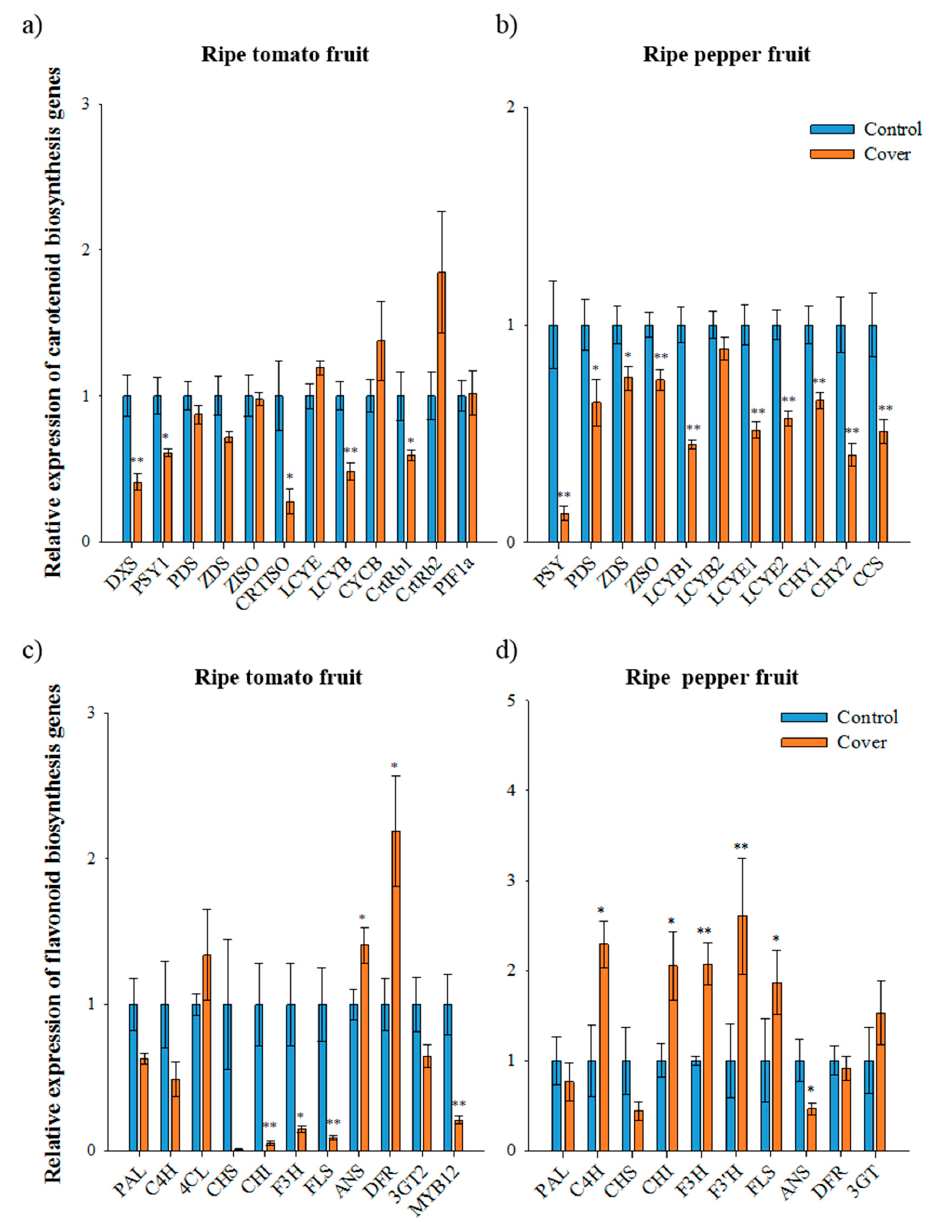
Figure 3. Relative expression of carotenoid and flavonoid biosynthetic genes in ripe fruits under normal and cover conditions analyzed using qRT-PCR. The expression of carotenoid biosynthetic genes in ripe tomato fruit (second trial) ( a ) and ripe pepper fruit (first trial) ( b ). The expression of flavonoid biosynthetic genes in ripe tomato fruit (second trial) ( c ) and ripe pepper fruit (first trial) ( d ). Data represents the mean of at least three biological replicates and the error bars indicate standard error (SE). The asterisk * and ** indicate a significant difference at p < 0.05 and p < 0.01, respectively, according to an independent t -test.